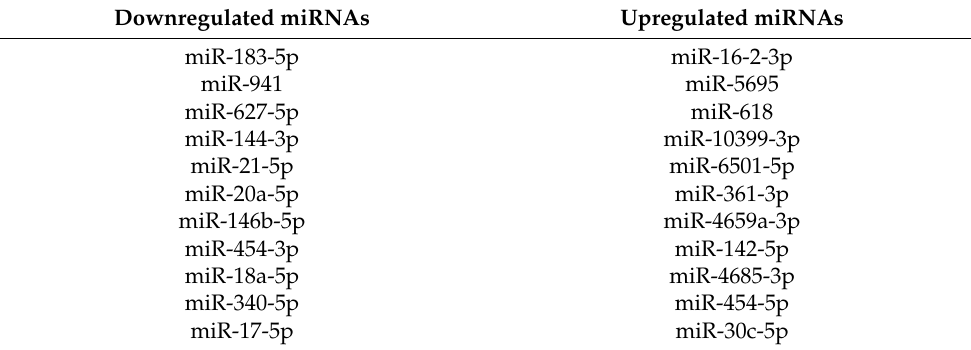
Table 1. The most up- and downregulated miRNAs from peripheral blood of COVID-19 patients in comparison to the healthy donors’ samples. Expression levels of various miRNAs were detected by sequencing, and correlation analysis was performed on the target genes. The results confirm that miRNAs in COVID-19 patients could regulate immune responses and viral replication during viral infection